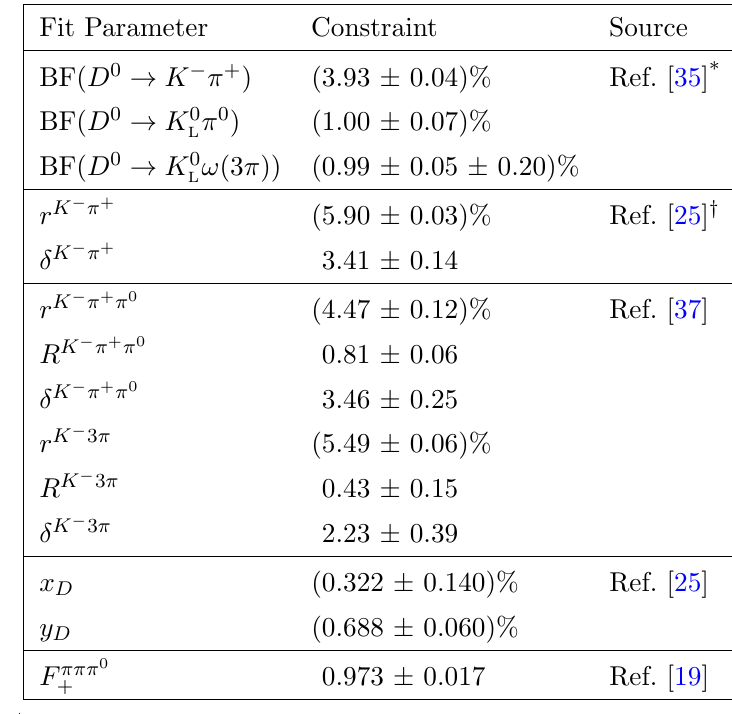
Table 4 . List constraints used in the analysis. The right hand column gives the source of the con- straint, along with any conventional adjustments that have to be made to use them in this analysis.